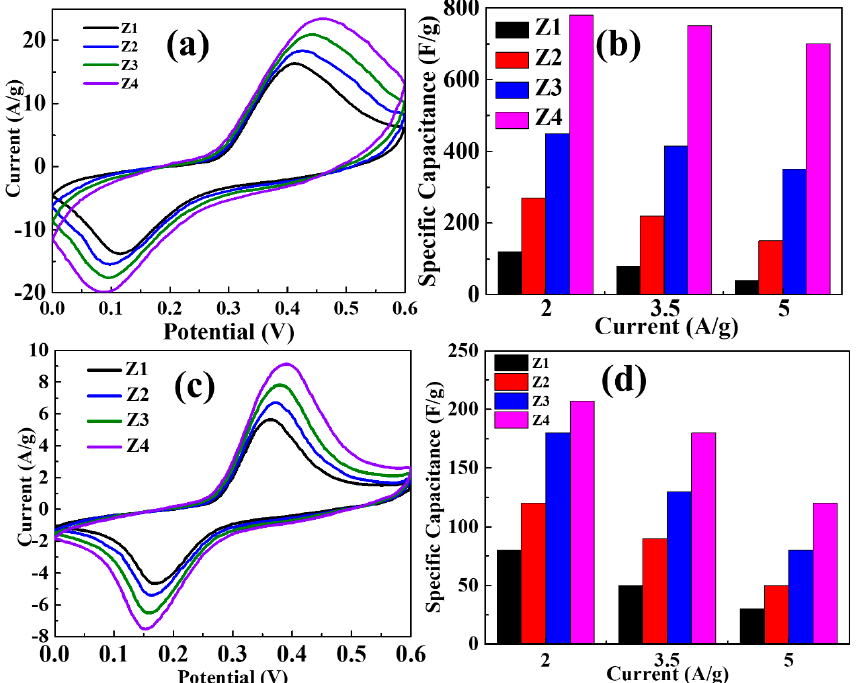
Figure 8. ( a ) and ( b ) show the cyclovoltammetry curves and specific capacitance against current Figure 8. ( a , b ) show the cyclovoltammetry curves and specific capacitance against current density density for synthesized ZnO dried at 80 °C; ( c ) and ( d ) show the cyclovoltammetry curves and for synthesized ZnO dried at 80 ◦ C; ( c , d ) show the cyclovoltammetry curves and specific capacitance specific capacitance against current density for synthesized ZnO dried at 250 °C. against current density for synthesized ZnO dried at 250 ◦